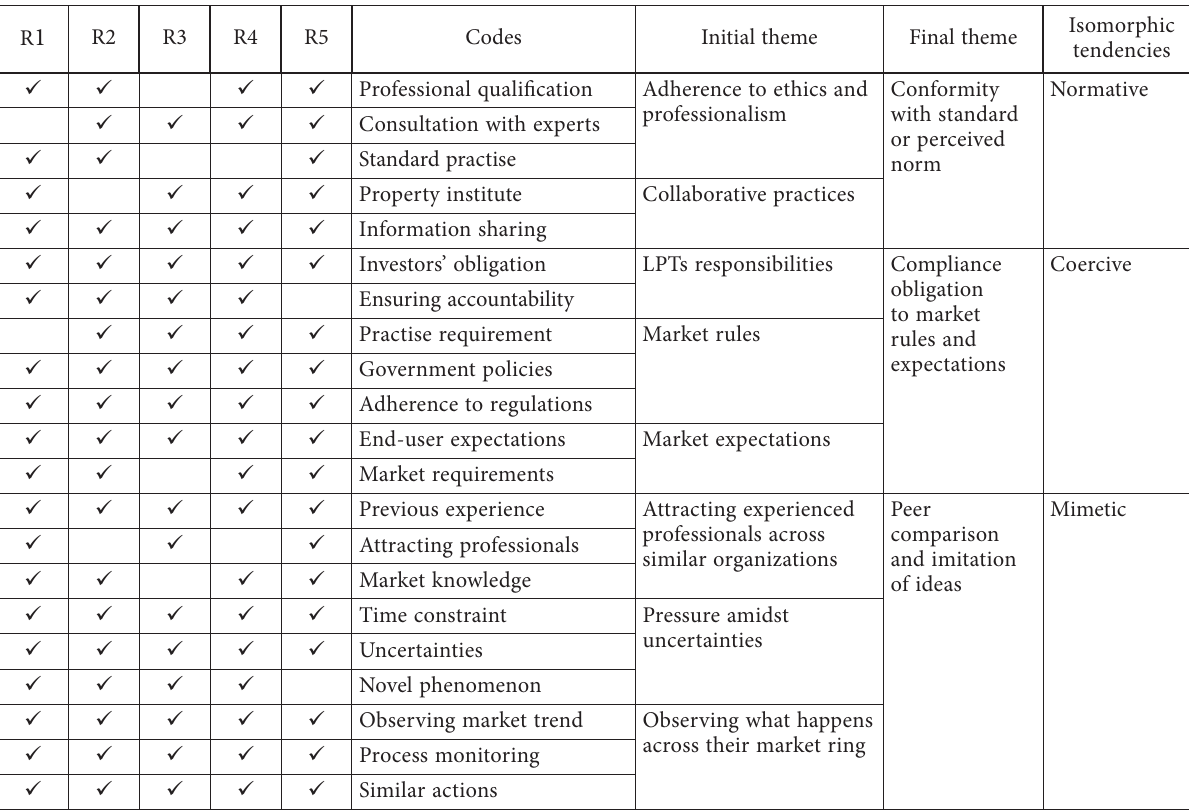
Table 2. Isomorphic tendencies that impact the disruption-driven investment decision-making of LPTs R